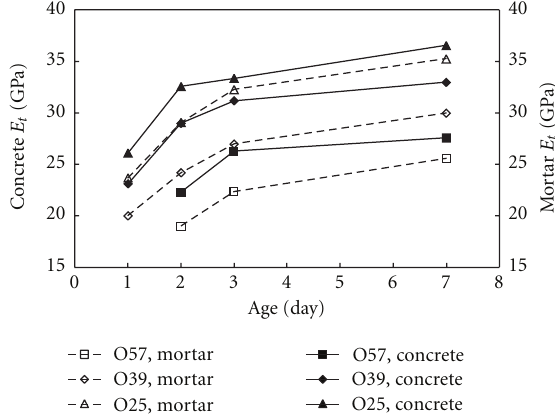
Figure 11: Tensile Young’s modulus predicted by employing grids of di ff erent